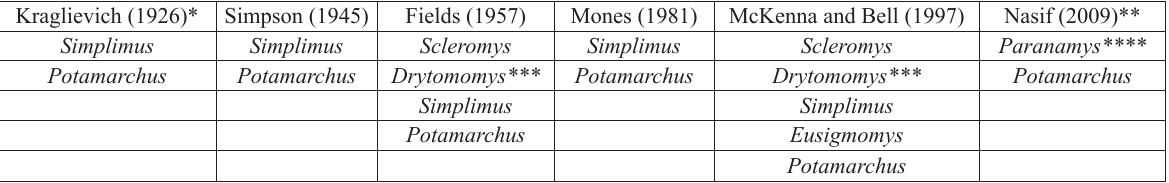
Table 1. Classifications of Potamarchinae. * used in family level Potamarchidae; ** defined as a monophyletic group; *** see taxonomic history of Drytomomys in Candela and Nasif (2006), **** Paranamys was recently revalidated (Nasif 2009; Nasif et al. 2013), after this, the genus Dry- tomomys encompasses only taxa from the Neogene of northern South